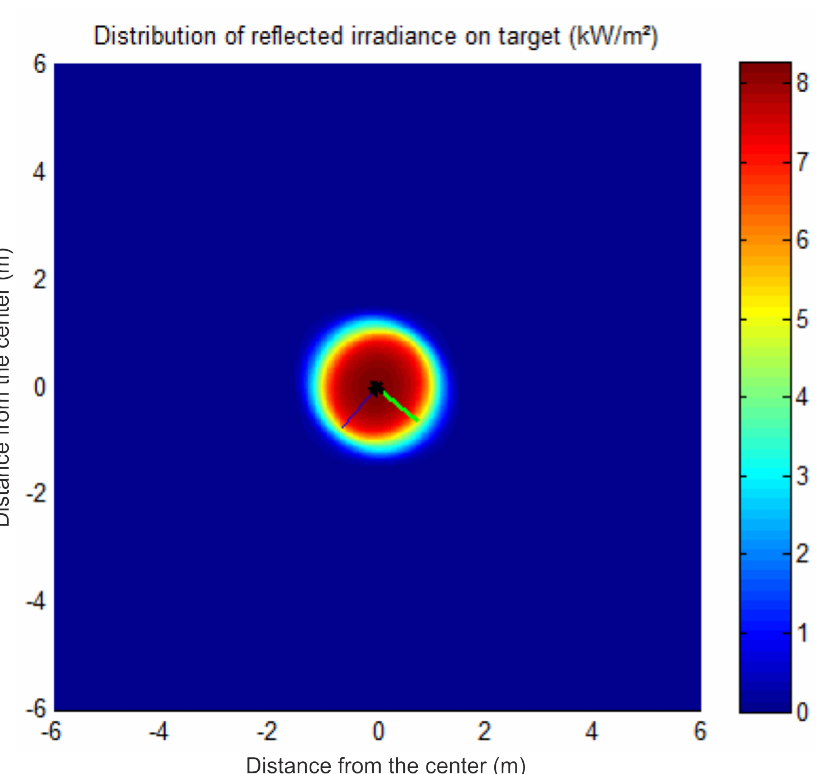
Figure 7. Flux distribution on the target (9 March 2017 at 14:02 UTC).